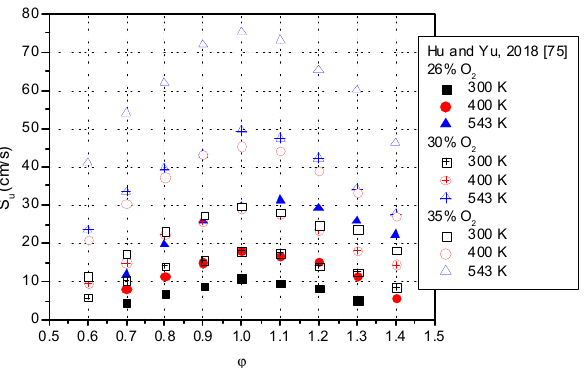
Figure 21. Influence of initial temperature on experimental laminar burning velocity of oxygen-